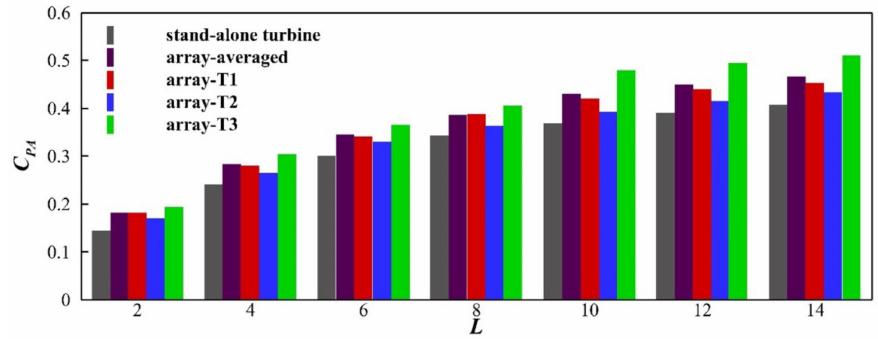
Figure 13. Comparison of averaged power coefficients of self-starting turbines.